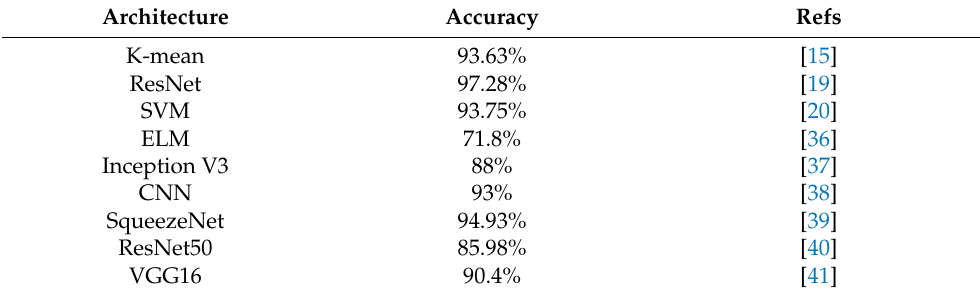
Table 4. Results obtained by other